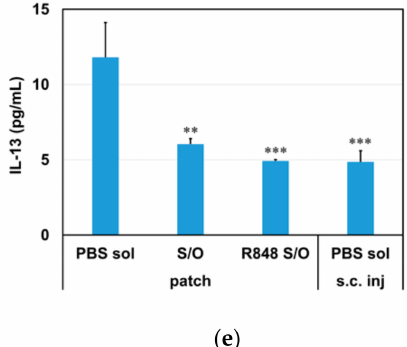
Figure 4. Cytokine levels after splenocyte stimulation with whey protein. ( a–e ) Levels of IFN- γ ( a ), IL-4 ( b ), IL-10 ( c ), IL-12 p40 ( d ), and IL-13 ( e ) in the supernatant of splenocytes from mice treated as described in Figure 3a following stimulation with whey protein. The cytokine concentrations in the cell cultures 24 h after stimulation with antigen were determined using sandwich ELISA kits. Data are shown as the mean + SD ( n = 6). Statistical analysis was performed using an ANOVA and Tukey’s post-hoc test for multiple comparisons. *, p < 0.05; **, p < 0.01; and ***, p < 0.001 compared with the BLG dissolved in PBS (PBS sol); &1, p < 0.05 and &2, p < 0.01 compared with the subcutaneously injected BLG in PBS solution (PBS sol. s.c. inj).